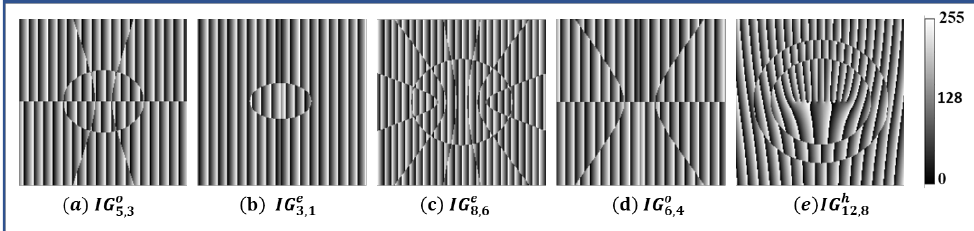
Figure 4. Computer-generated hologram for different Ince–Gaussian beams. ( a ) IG o ( c ) IG e , ( d ) IG o , ( e ) IG h for (cid:101) = 8,6 6,4 12,8